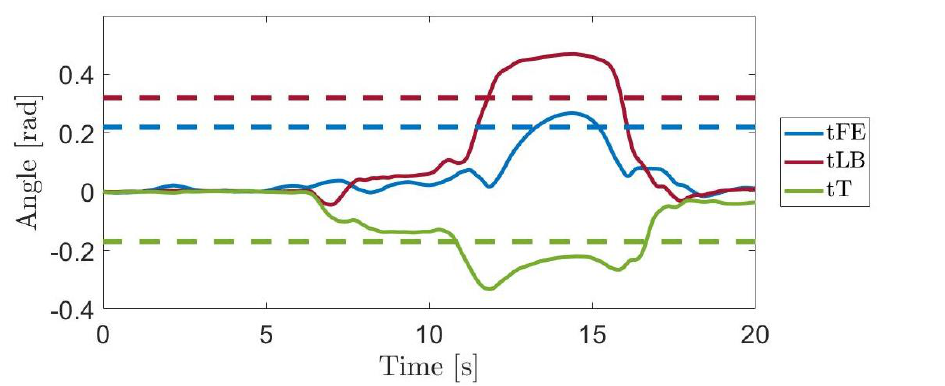
Figure 6. Rotations of the trunk recorded during the test trial. The dashed horizontal lines stand for the maximum threshold values suggested by the